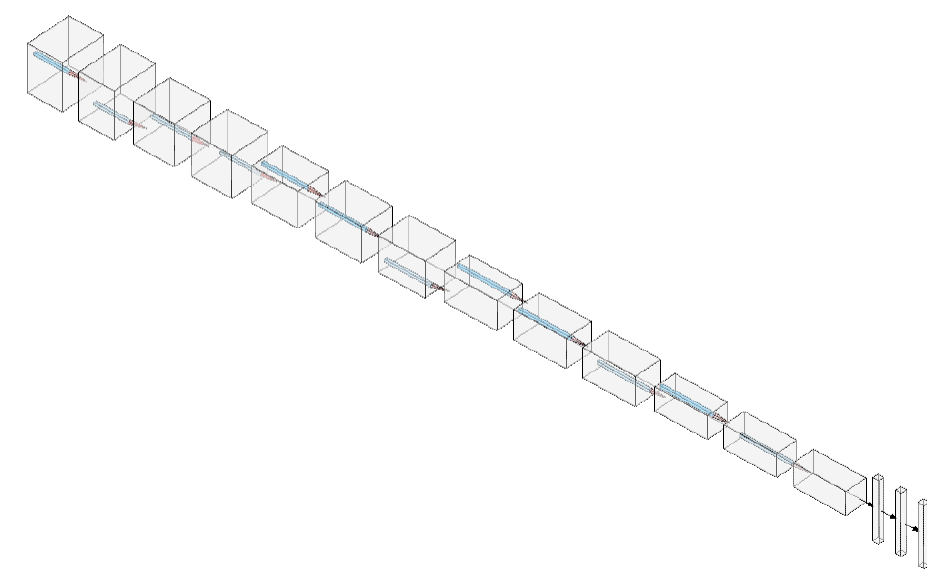
Figure 3. The architecture of the VGG-16 CNN network.